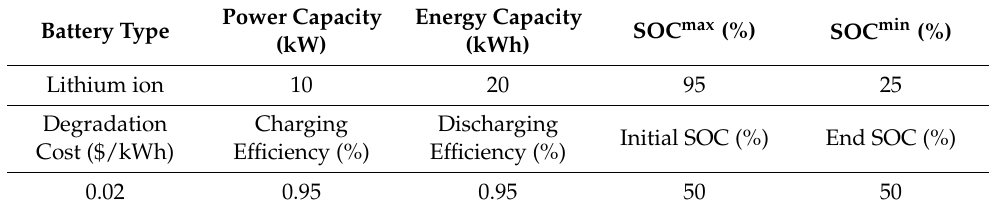
Table 3. Parameters of batteries.